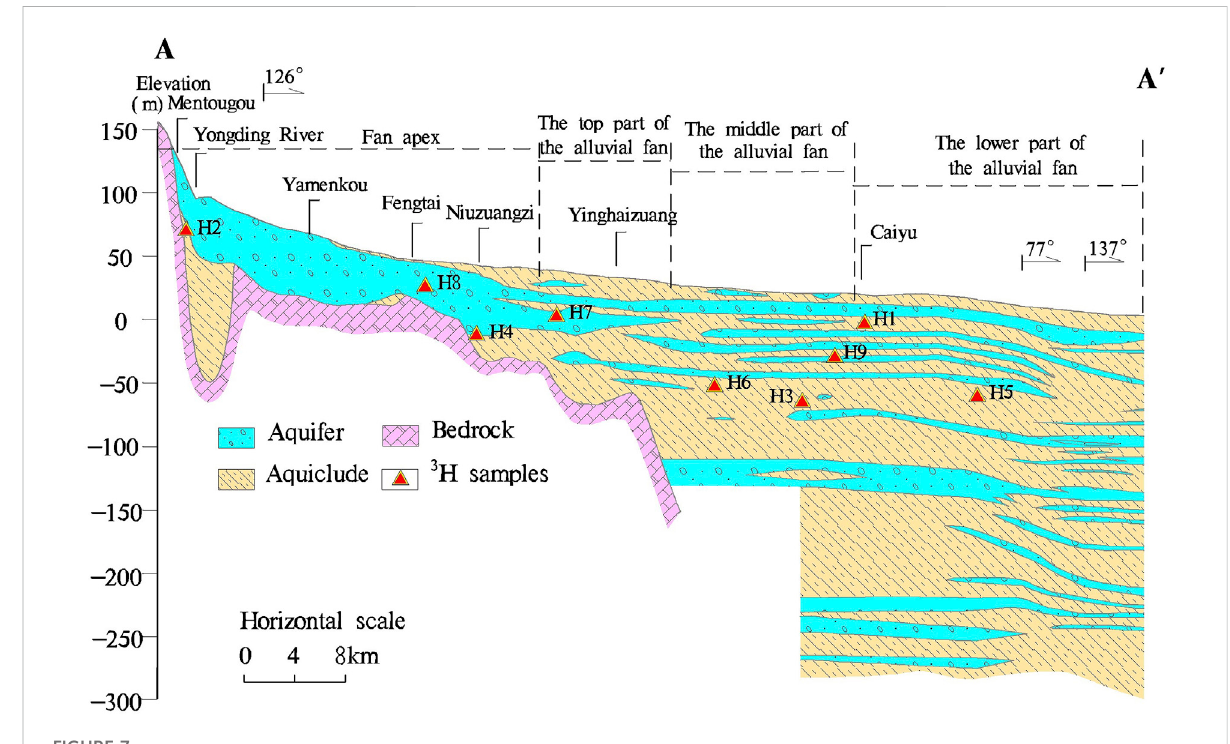
FIGURE 7 Distribution of 3 H sampling